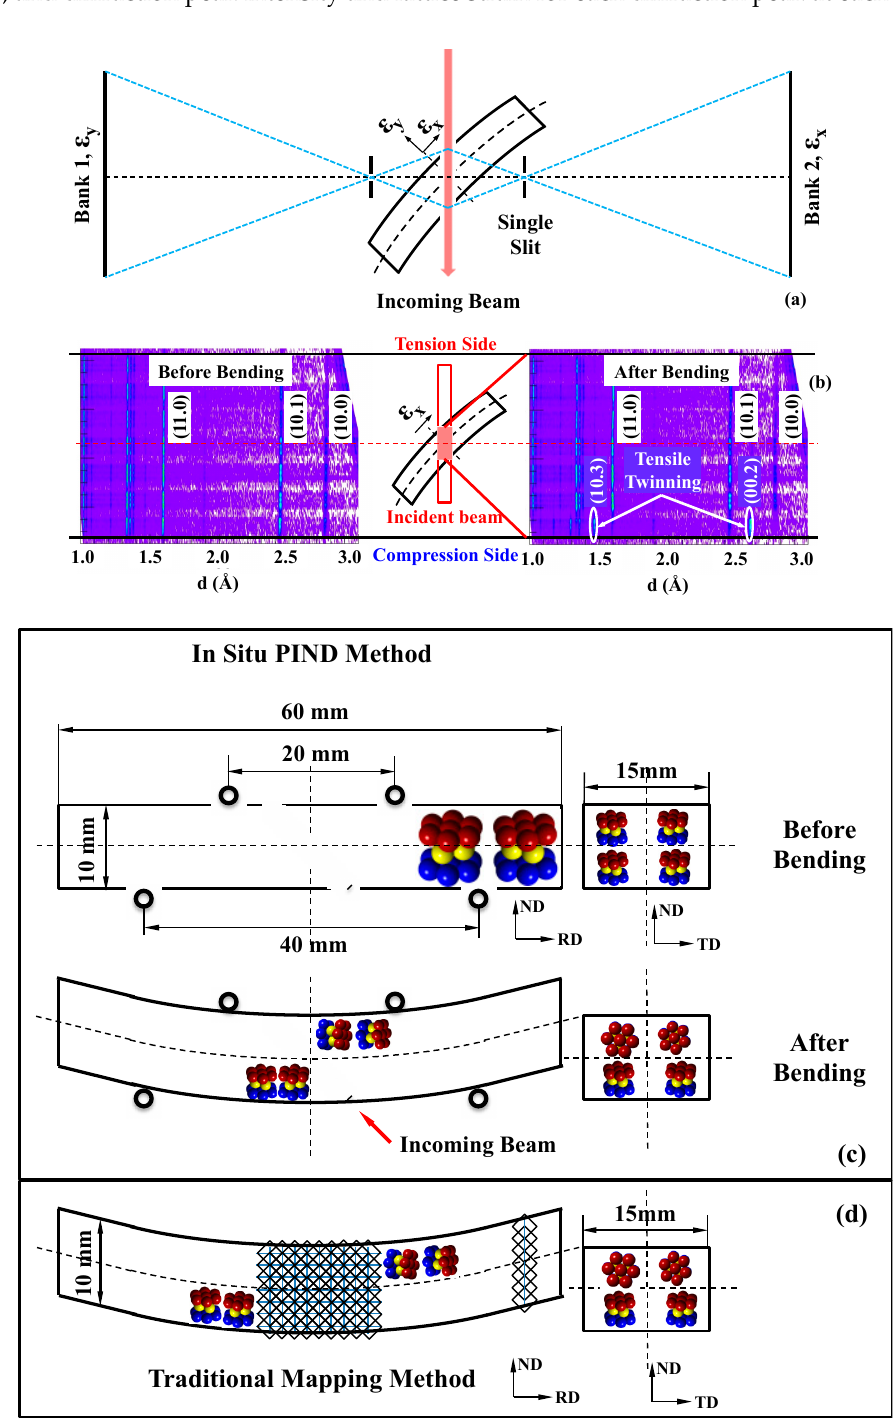
Figure 2. ( a ) The schematics of the high spatial resolution PIND method; ( b ) The neutron diffraction patterns before and after the bending test; ( c ) The schematics of the in situ four-point bending experiment using PIND method; ( d ) The schematics of traditional neutron diffraction mapping setup.